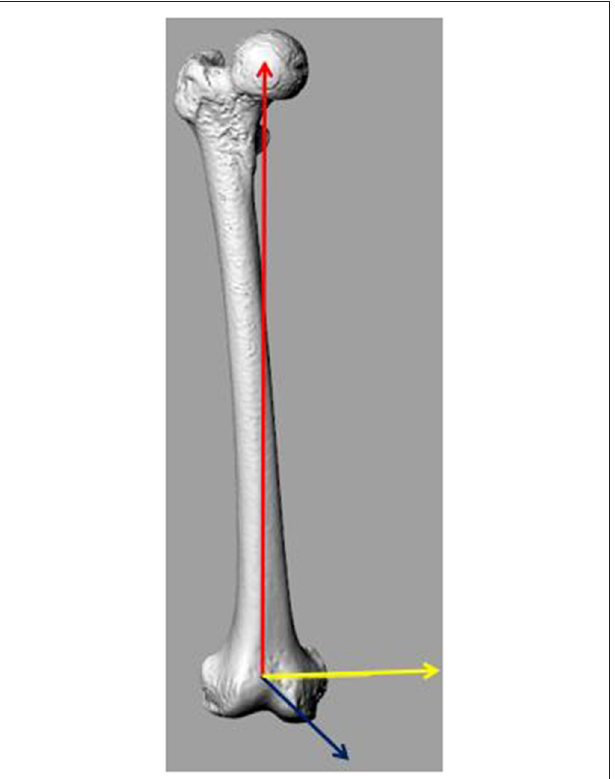
FIGURE 1 | Femur coordination. The mechanical axis (MA) is defined as the line connecting the geometric center of the femoral head and the midpoint of the surgical transepicondylar axis (sTEA) (i.e., Y-axis; the red line). The sTEA is indicated by the yellow line. The Z-axis plane is created perpendicular to the MA, passing the midpoint of the sTEA. The X-axis (the blue line) is perpendicular to the plane formed by the Y- and